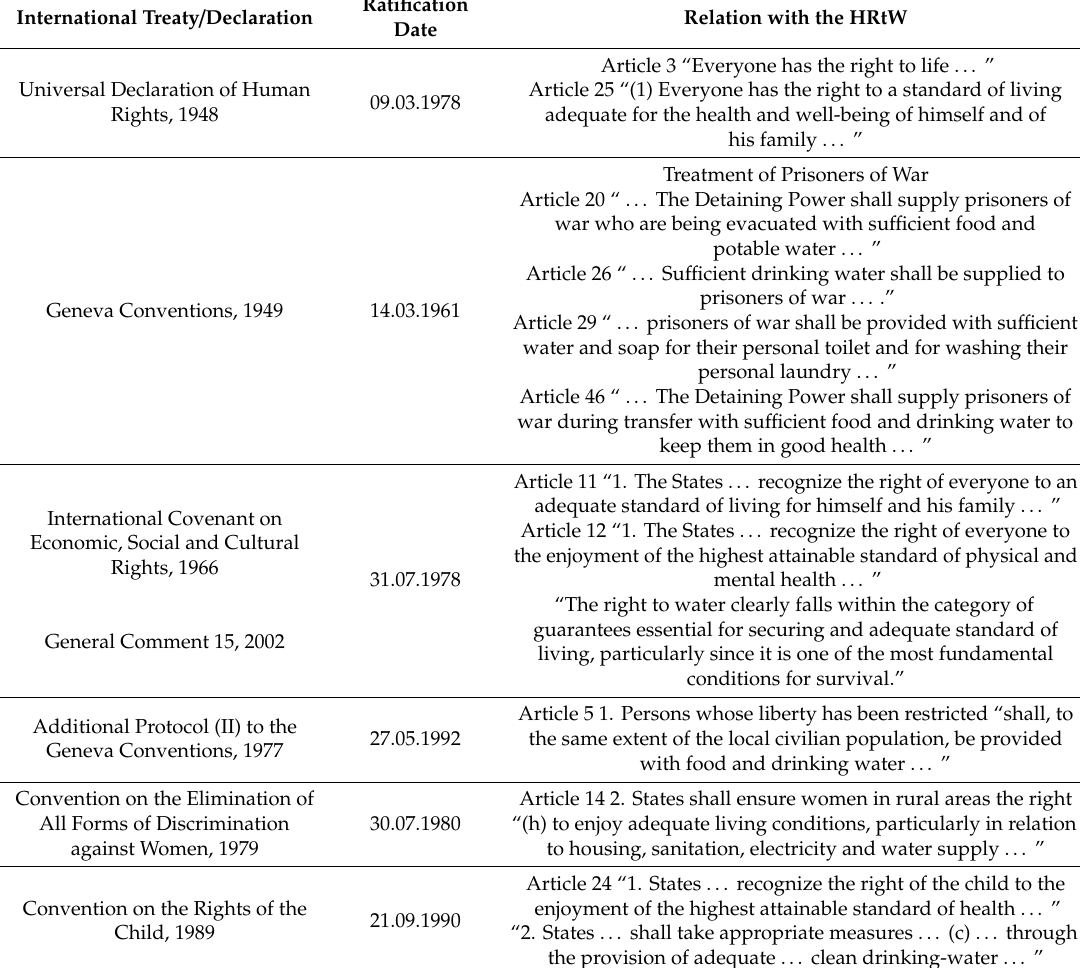
Table 1. Major international treaties ratified and declarations adopted by